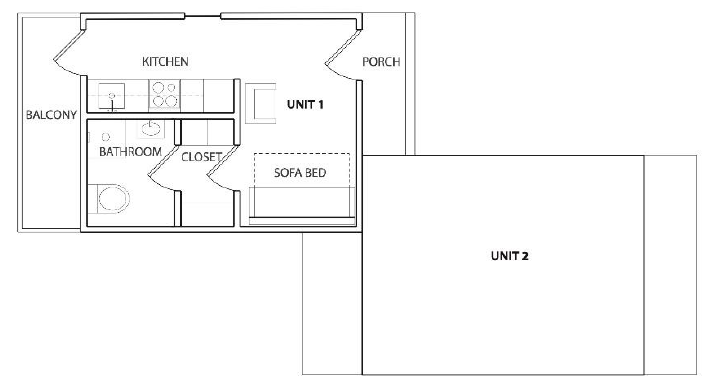
Figure 3. Construction on two new tiny homes was completed in 2022. They were designed pro bono by the Indianapolis-based architecture firm, DKGR, who first heard about MSH’s work through its online platforms.